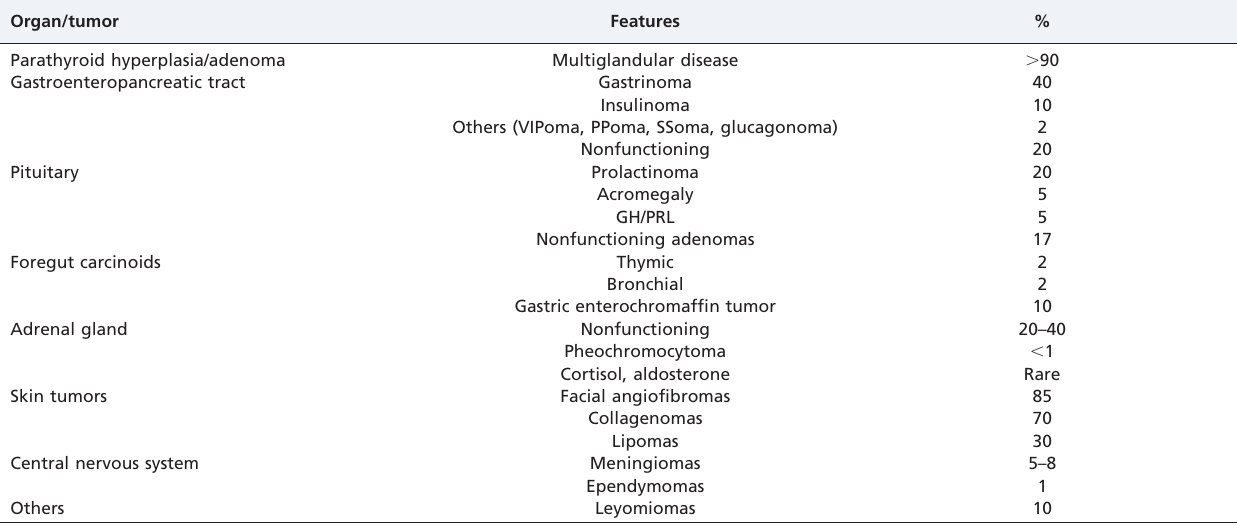
Table 1 - MEN1-related tumors (penetrance at age 40).